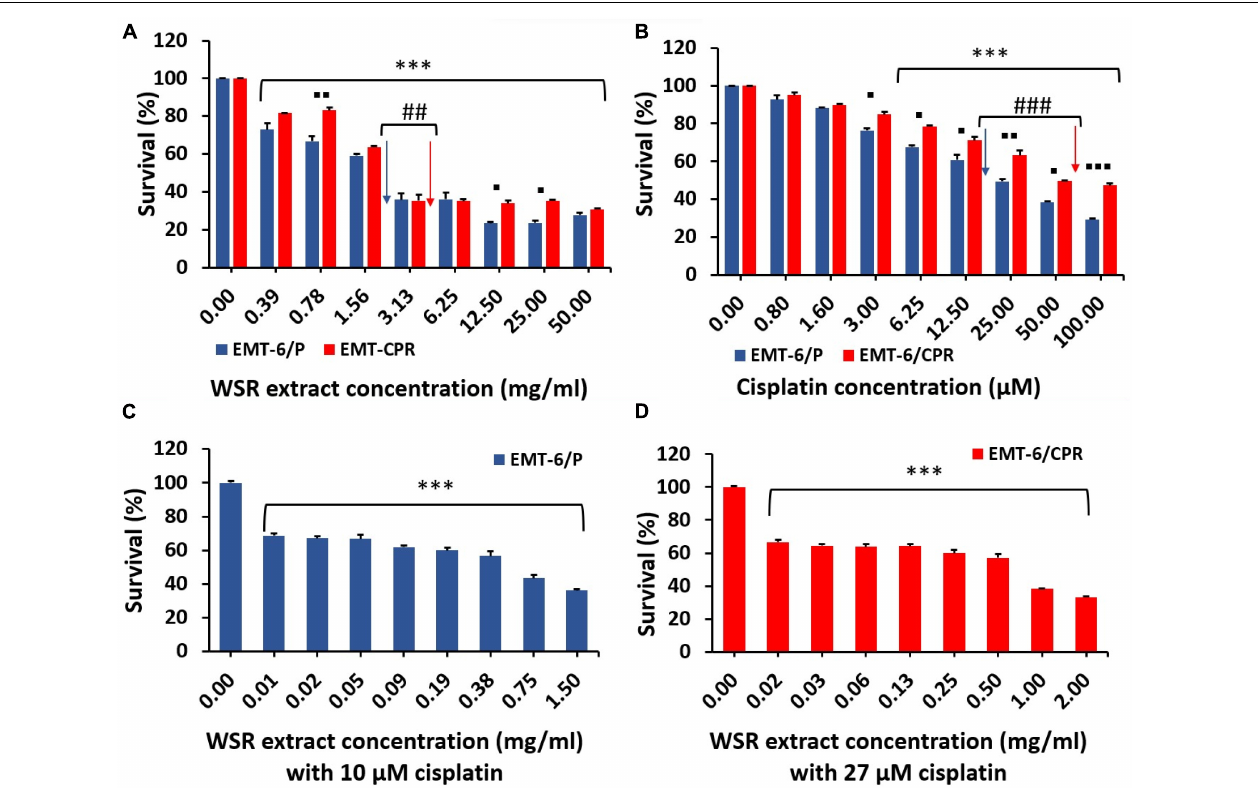
FIGURE 4 | Antiproliferative effect of WSR extract, cisplatin, and their combination against EMT6/P and EMT6/CPR cell lines. (A) Treatment of both cell lines with an increasing concentration of WSR extract. (B) Treatment of both cell lines with an increasing concentration of cisplatin. (C) Antiproliferative activity of various concentrations of WSR extract with 10 µ M cisplatin against EMT6/P cell lines. (D) Antiproliferative activity of various concentrations of WSR extract with 27 µ M cisplatin against EMT6/CPR cell lines. Data are presented as mean ± SEM ( n = 3). ∗ P < 0.05, ∗∗ P = 0.001, ∗∗∗ P < 0.001. ## P = 0.001, ### P < 0.001. (cid:4) P < 0.05, (cid:4)(cid:4) P = 0.001, (cid:4)(cid:4)(cid:4) P <0.001. ( ∗ : treatments groups compared with the control (0.00 µ M), (cid:110) : EMT6/P survival compared with EMT6/CPR survival, # : survival of EMT6/P at IC 50 compared with the survival of EMT6/CPR at IC 50 concentration). TABLE 2 | IC 50 values for the extract and cisplatin in cisplatin-sensitive (EMT6/P) and cisplatin-resistant (EMT6/CPR) cell lines along with the combination index, related interpretation, and resistance fold. Cell line IC 50 of WSR extract IC 50 of cisplatin WSR extract IC 50 in Cisplatin IC 50 in CI Interpretation (mg/mL) ( µ M) combination (mg/mL) combination ( µ M) EMT6/P 2.9 ± 0.18 20 ± 0.5 0.54 ± 0.011 0.78 Moderate synergism EMT6/CPR 3.8 ± 0.09 54 ± 0.08 Moderate